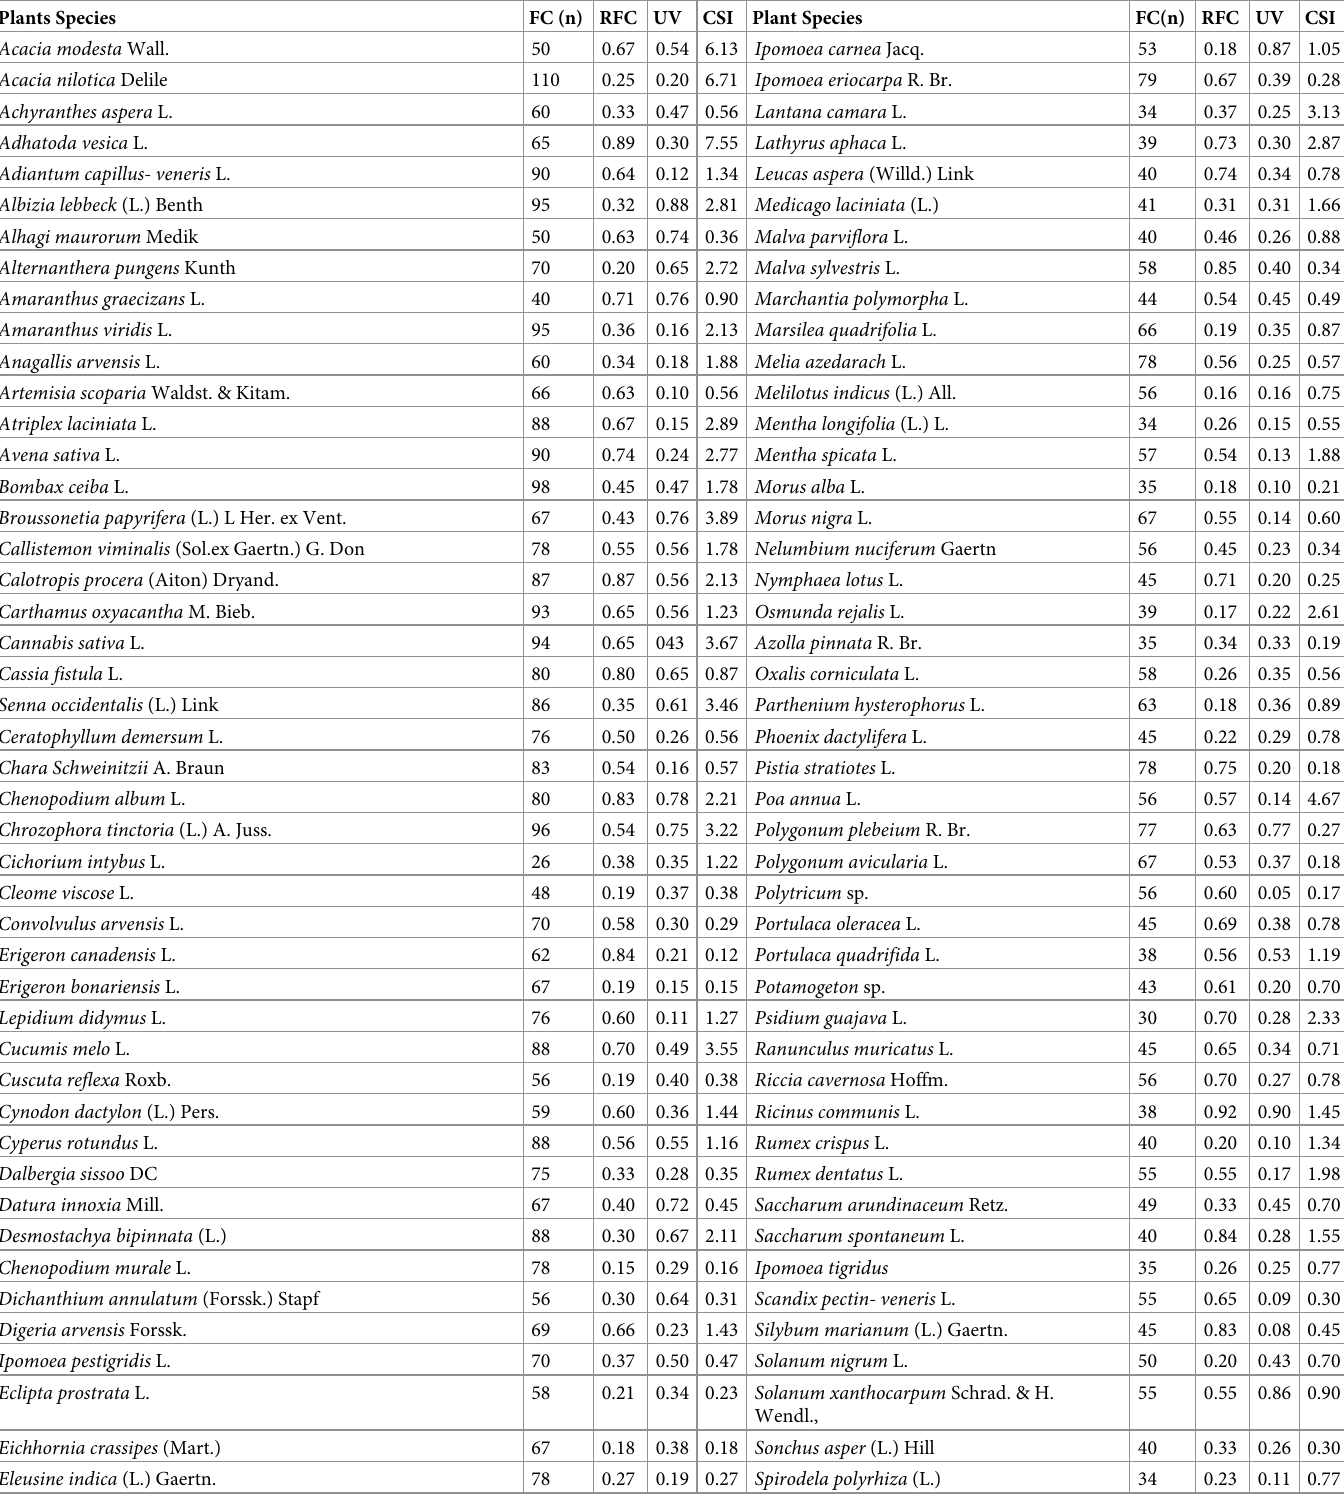
Table 4. Plants with frequency of citations (FC), relative frequency of citations (RFC), use value (UV) and cultural significance index (CSI)